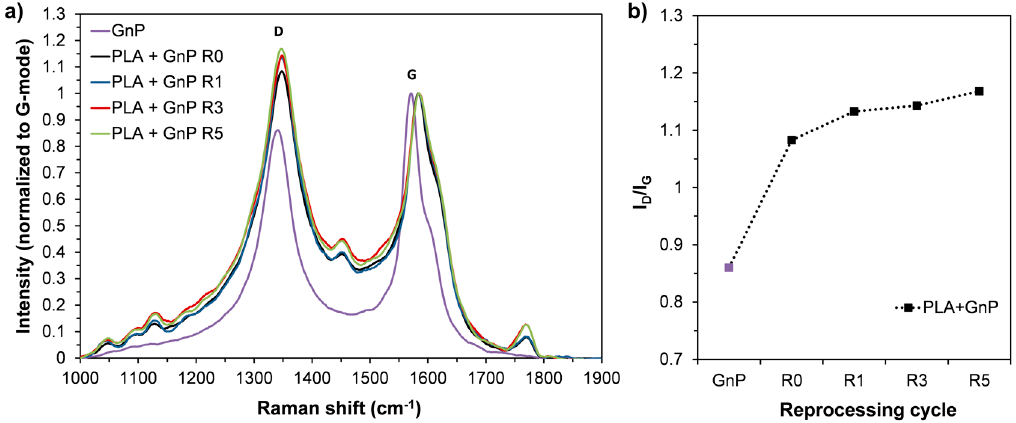
Figure 6. ( a ) Raman spectra normalized to G-mode of neat GnP and PLA + GnP nanocomposites at different reprocessing cycles; ( b ) I D /I G as a function of reprocessing cycles for neat GnP and PLA + GnP systems.